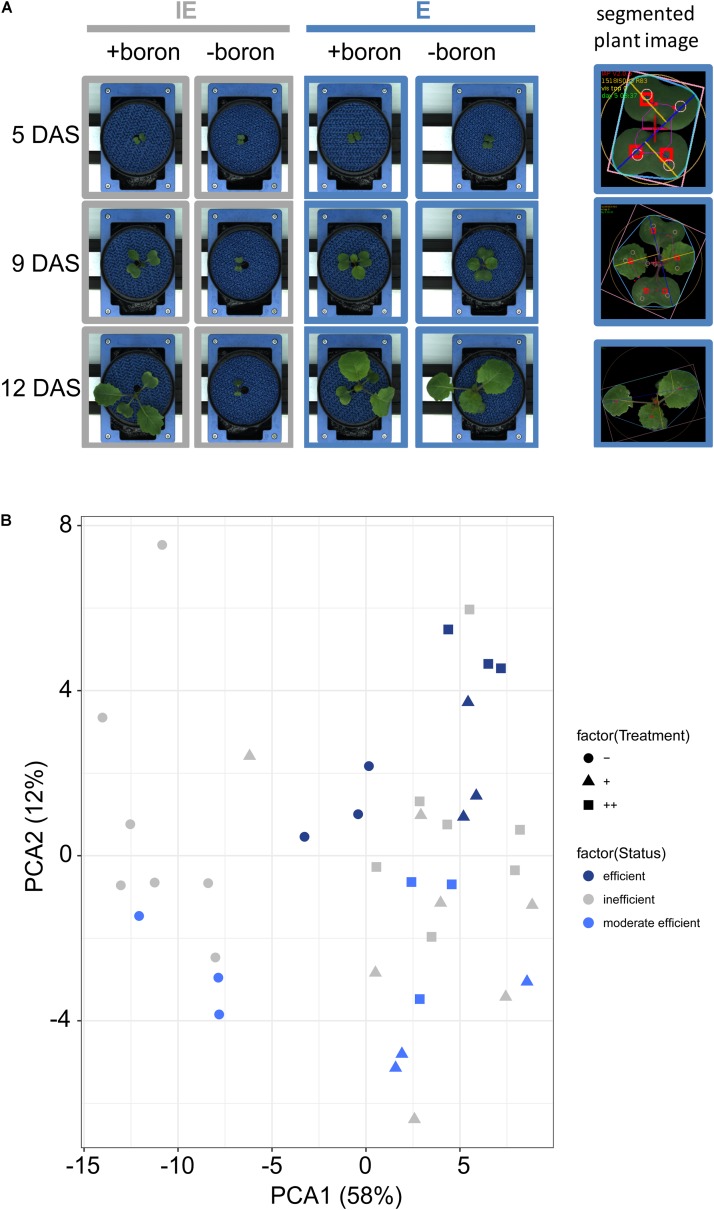
B-dependent growth behavior and analyses of B. napus cultivars grown in a LemnaTec cultivation system. (A) Left panel: Exemplary pictures of selected cultivars [IE (CR2262) = B deficiency-sensitive cultivar; E (CR2267) = B deficiency-tolerant cultivar] growing in B-deficient (-boron) or B-sufficient (+boron) zerosoil-substrate taken at days 5, 9, or 12 after sowing (DAS). Right panel: segmented plant images which are used for image analysis. (B) Principal component analysis (PCA) for 13 rapeseed cultivars based on recorded imaging-based growth parameters. Symbols indicate different B soil substrate conditions [ = B-deficient (-),  = B-sufficient (+) or  = B-surplus (++) conditions].